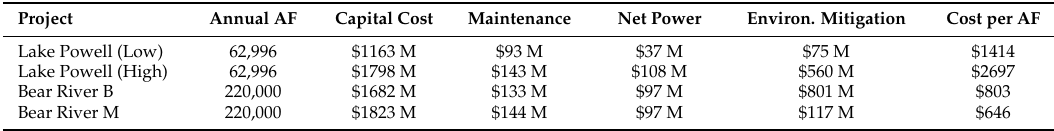
Table 4. Development project present value